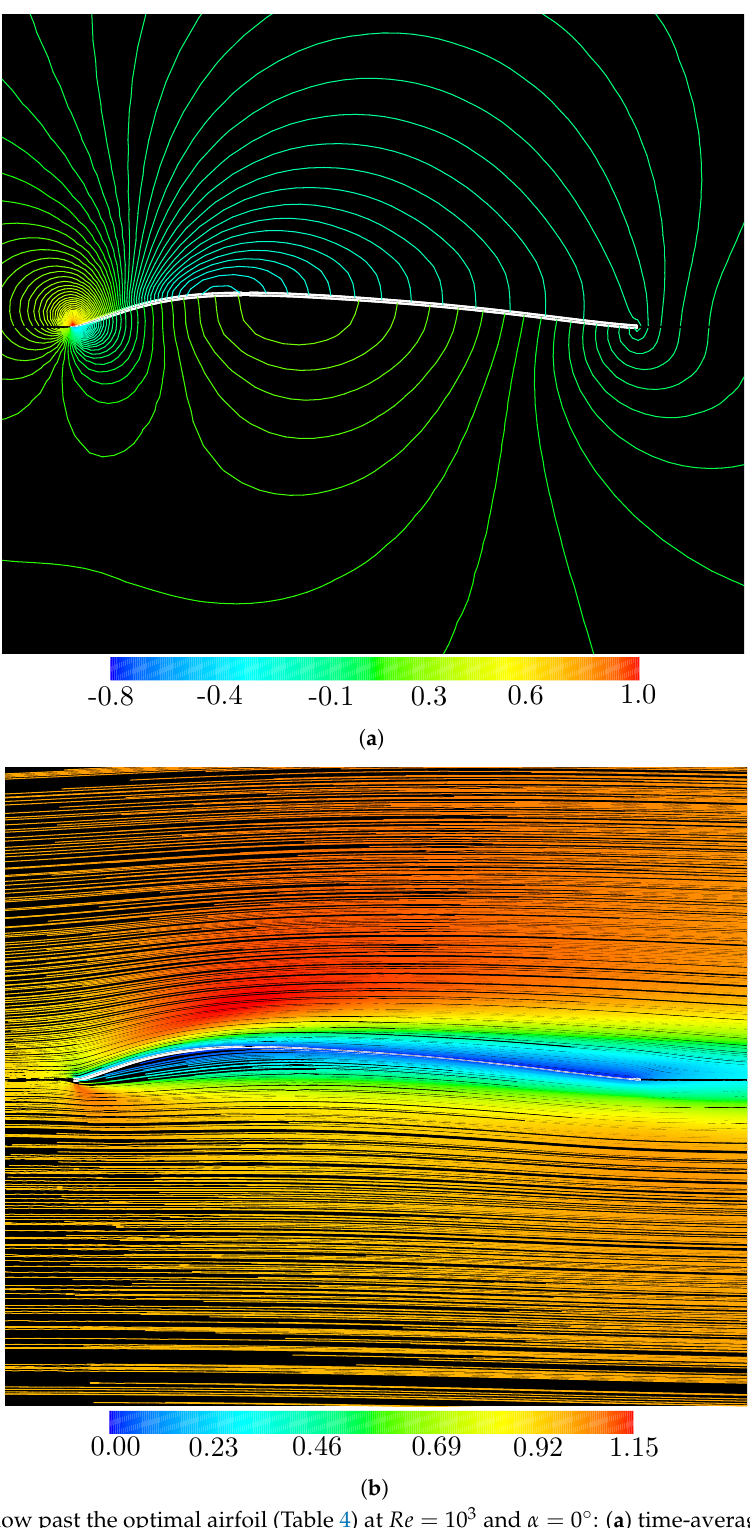
Figure 16. Flow past the optimal airfoil (Table 4) at Re = 10 3 and α = 0 ◦ : ( a ) time-averaged pressure isolines; and ( b ) time-averaged